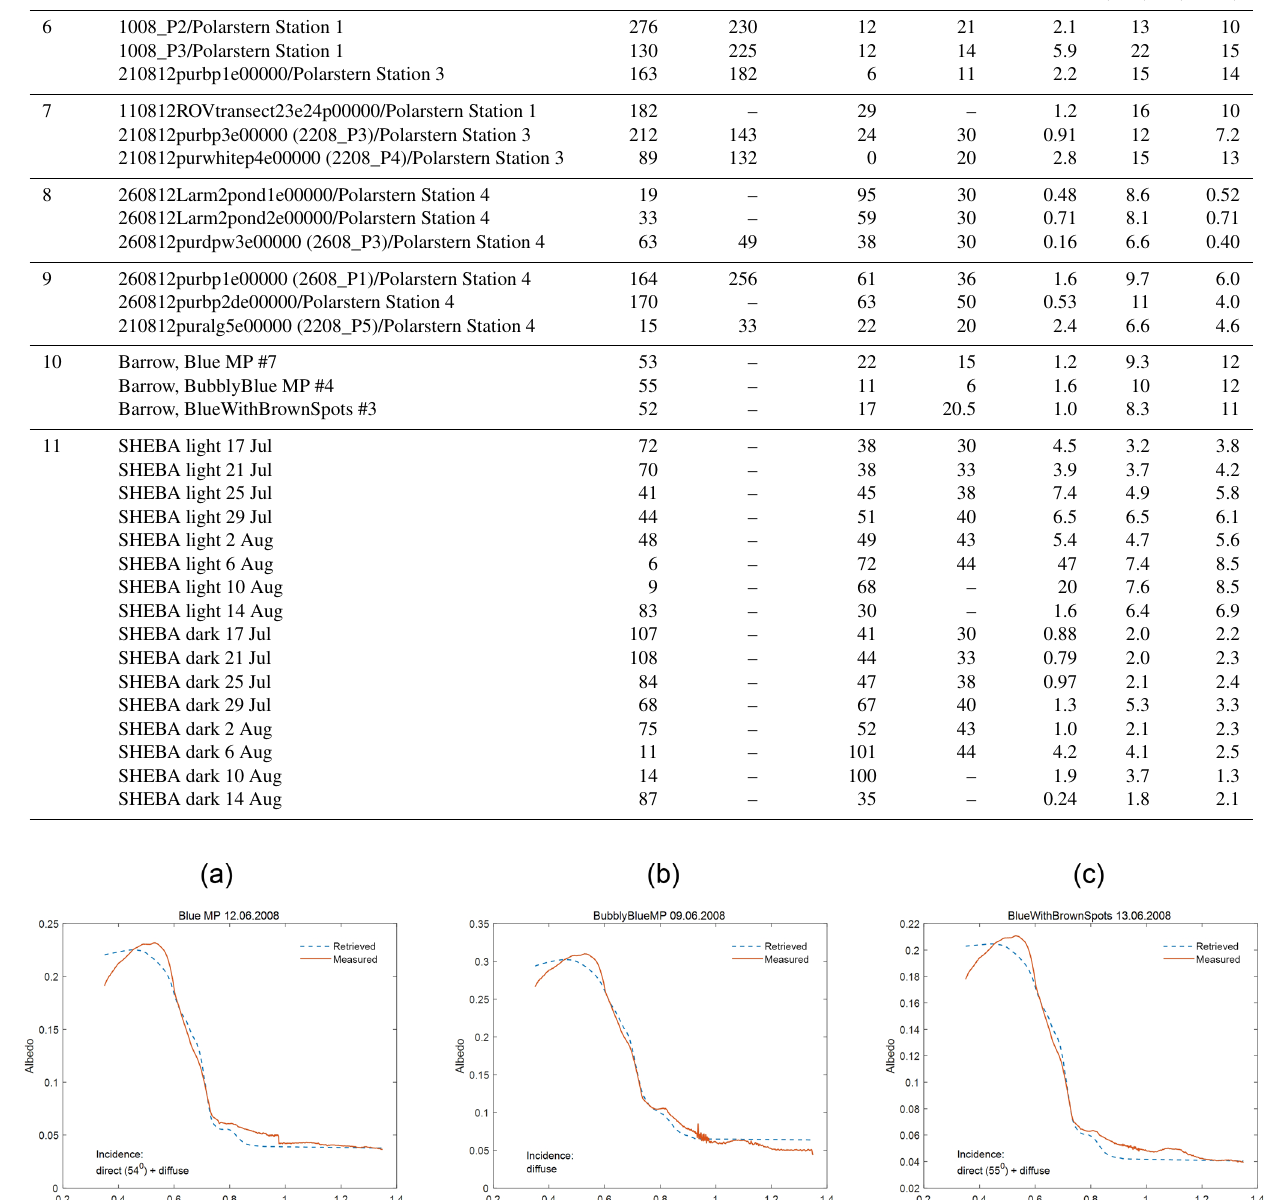
days. Therefore, the regression analysis relies on the first five measurement